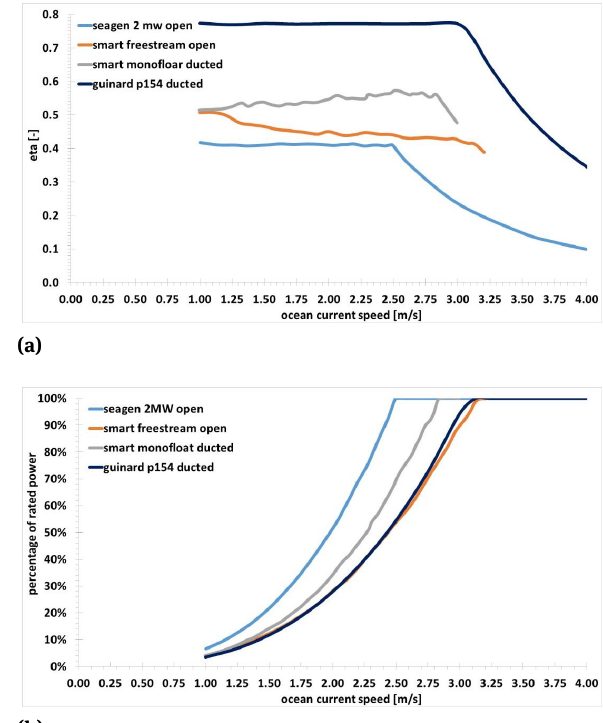
Figure 4: a) and b) Experimental power coefficient and power